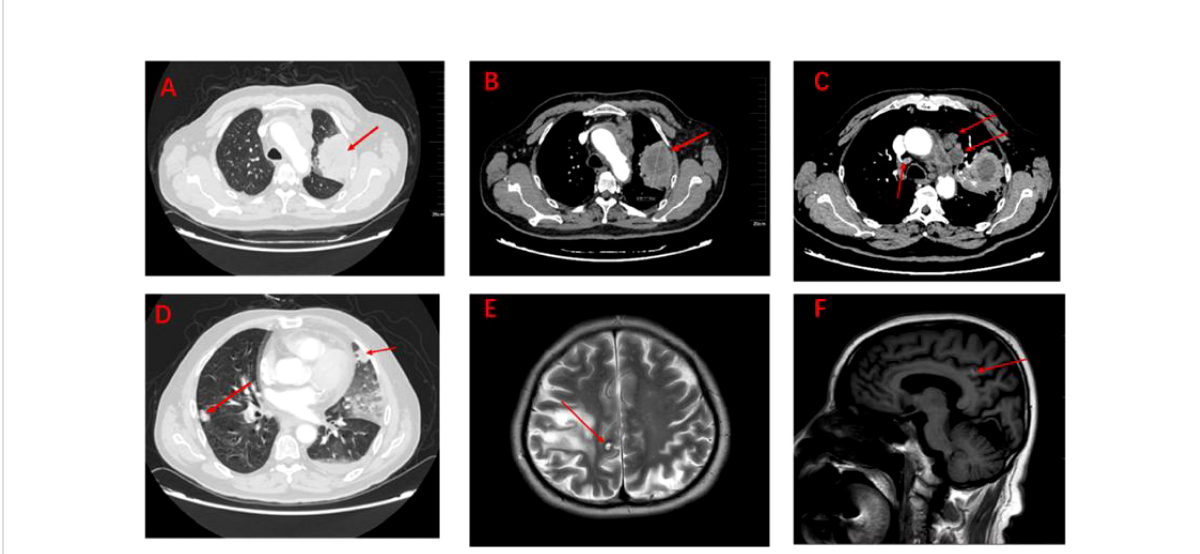
FIGURE 1 Imaging of tumour lesions at baseline (A – F) . (A) Pulmonary lesions under the lung window. (B) Pulmonary lesions under the mediastinum window (measuring 4.8cm x 4.6cm x 6.1cm). (C) Lymph node metastatic lesions under the mediastinum window. (D) Metastatic lesions in both lungs under the lung window. (E) Brain metastases under the coronal plane. (F) Brain metastases under the sagittal